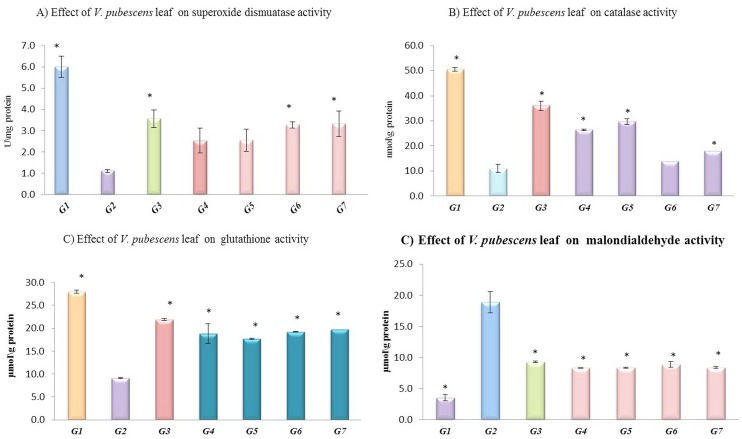
Effect of V. pubescens leaf extract on antioxidant activities of (A) superoxide dismutase, (B) catalase, (C) glutathione, (D) malondialdehyde. (G1) (Normal control group); (G) (Ulcer control group); (G3) (Omeprazole); (G4) (62.5 mg/kg), (G5) (125 mg/kg), (G6) (250 mg/kg) and (G7) (500 mg/kg) of V. pubescens extract. All values are expressed as the mean ± SEM. *mean significant at (p <0.05) in rats pre-treated with omeprazole or V. pubescens extract compared to ulcer control group. There were 6 rats in each group of experiment.